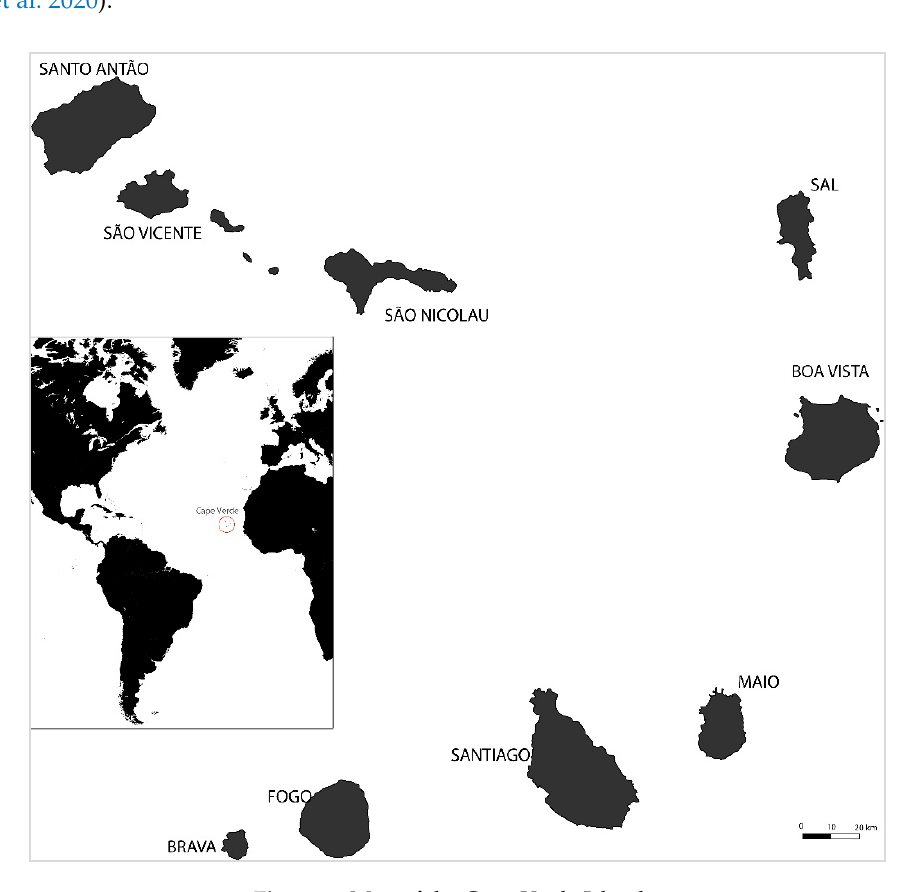
Figure 1. Map of the Cape Verde Islands.